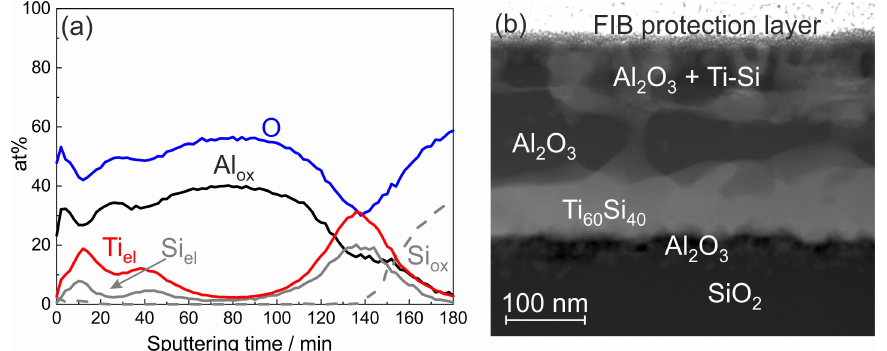
Figure 4. ( a ) Results of the XPS measurement of the ML sample with 20 nm individual layer thickness; and ( b ) STEM image with dominant chemical contrast, both after annealing at 800 ◦ C in HV. In ( a ), the subscript “el” refers to the elemental and “ox” to the oxidized state of the respective